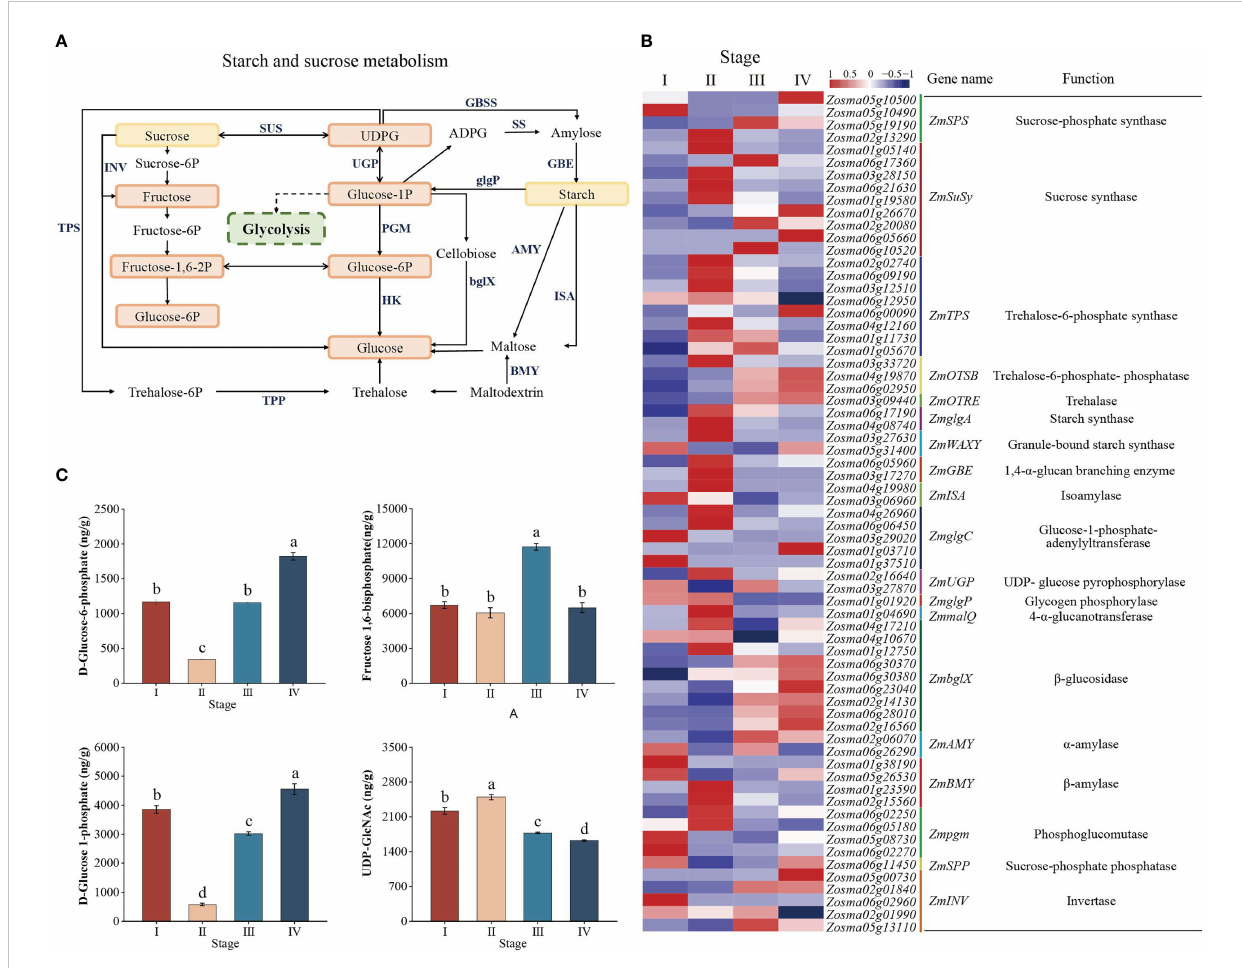
FIGURE 5 Starch and sucrose metabolism pathway. (A) Model and key components of starch and sucrose metabolism in Zostera marina seeds. The highlighted boxes indicate the metabolites quanti fi ed from the LC – MS/MS results. (B) Heatmap analysis of DEGs (log 10 (FPKM) values) involved in starch and sucrose metabolism. (C) Analysis of changes in the metabolites represented in starch and sucrose metabolism during Zostera marina seed